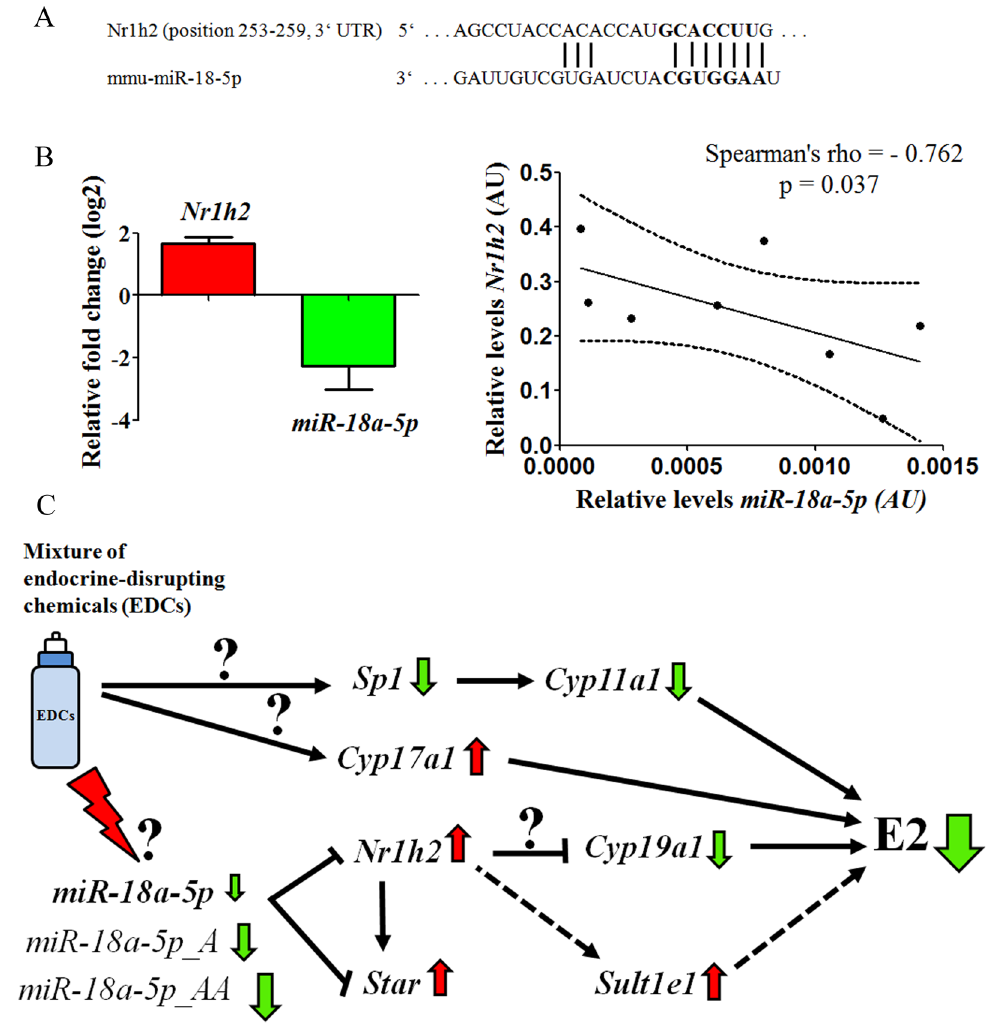
Figure 7. Down-regulation of miR-18a-5p in mice exposed to EDCs mixture is associated with estradiol decrease in testes via Nr1h2 . ( A ) Prediction of Nr1h2 as a target of miR-18a-5p , ( B ) mRNA expression of Nr1h2 and miR-18a-5p in the testes of mice exposed to EDCs mixture versus control mice by RT-qPCR, fold change (log 2 ) ± SEM, n = 4, and Nr1h2 : miR-18a-5p Spearman’s rank correlation coefficient (Spearman’s rho), * p < 0.05. Abbreviation: AU, arbitrary units. ( C ) Role of miR-18a-5p in the estradiol decrease in the testes of mice exposed to EDCs mixture (proposed model). Red arrow = up-regulated, green arrow =